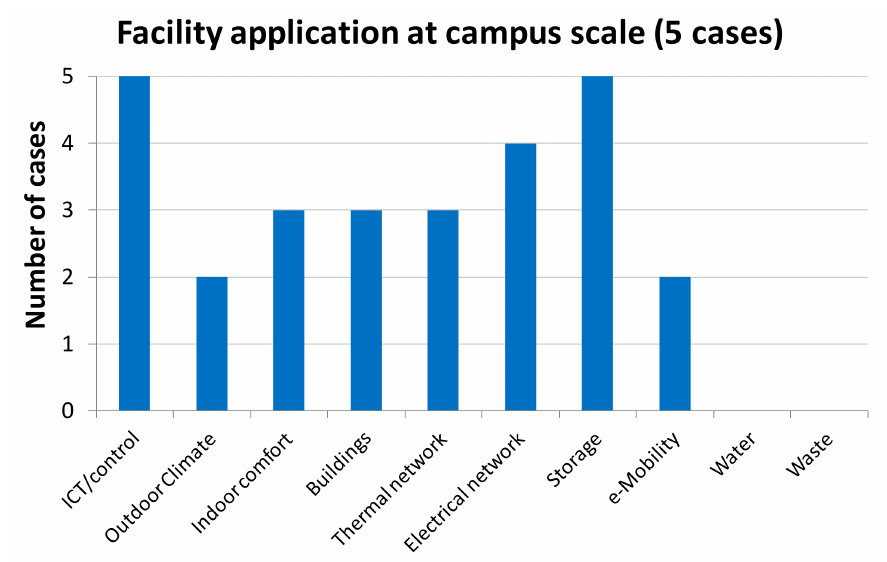
Figure 13. Histogram of occurrence obtained for the facility applications at the campus scale.